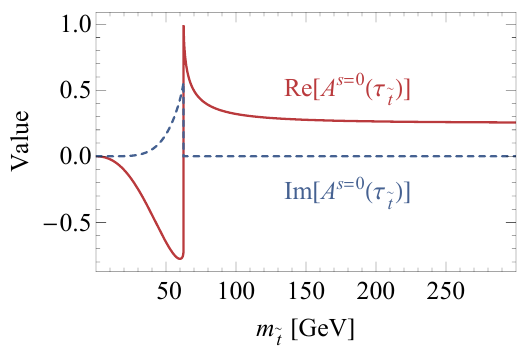
Figure 13 . The real and imaginary part of the pre-factor of A s=0 ( (cid:28)